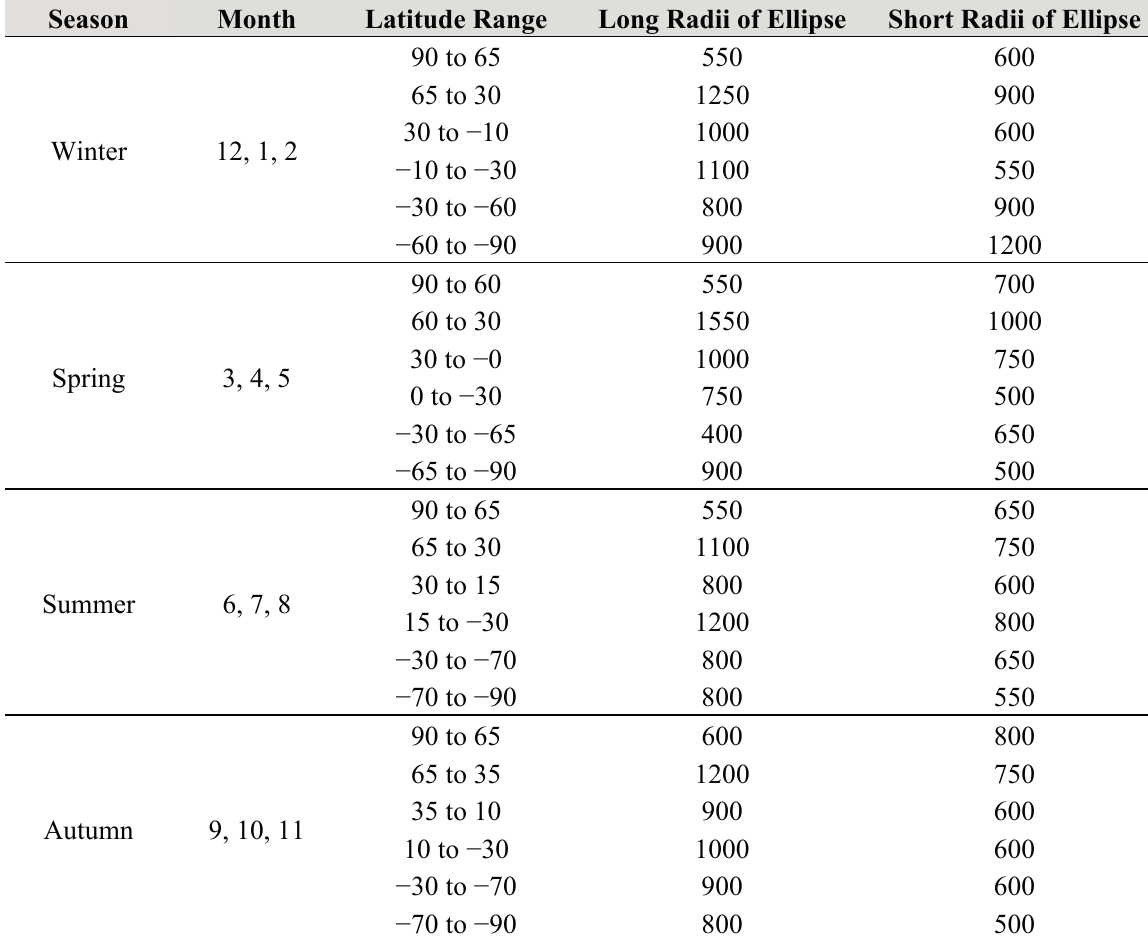
Table 1. Search range used in the interpolated processes (unit: